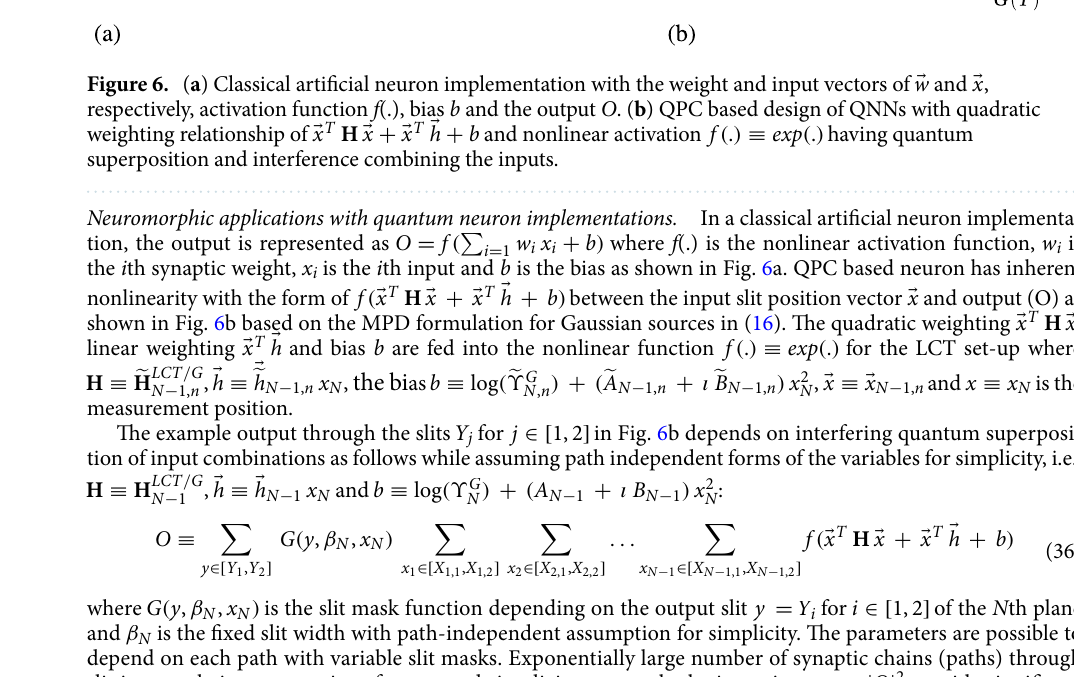
w and x , (cid:31) (cid:31) exp ( . ) having quantum ≡